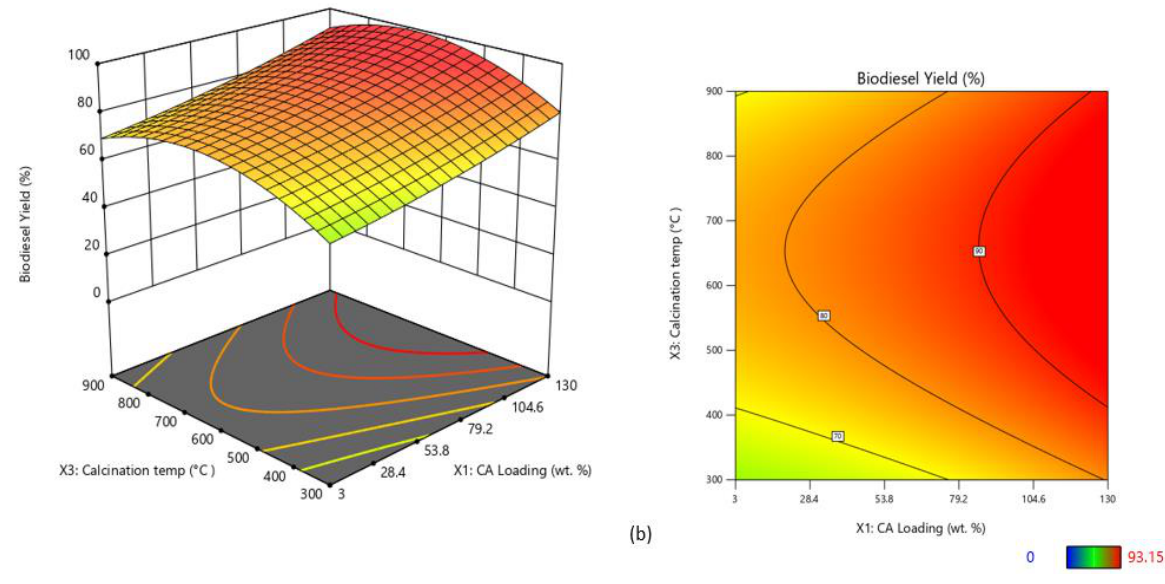
Figure 10. Three-dimensional surface and contour plots of biodiesel yield from the synthesized catalysts: ( a ) CaO/CA; ( b ) NaOH/CA.